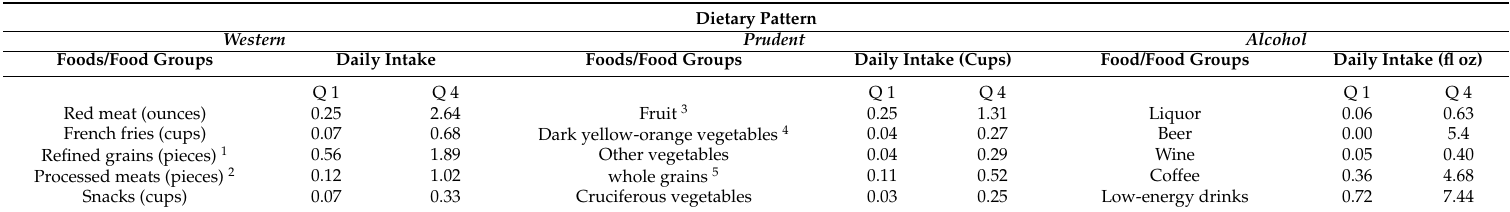
Table 3. Mean daily intake of participants with scores in the top and bottom quartile (Q4 and Q1, respectively) of the three dietary patterns for the foods/food groups with the highest factor